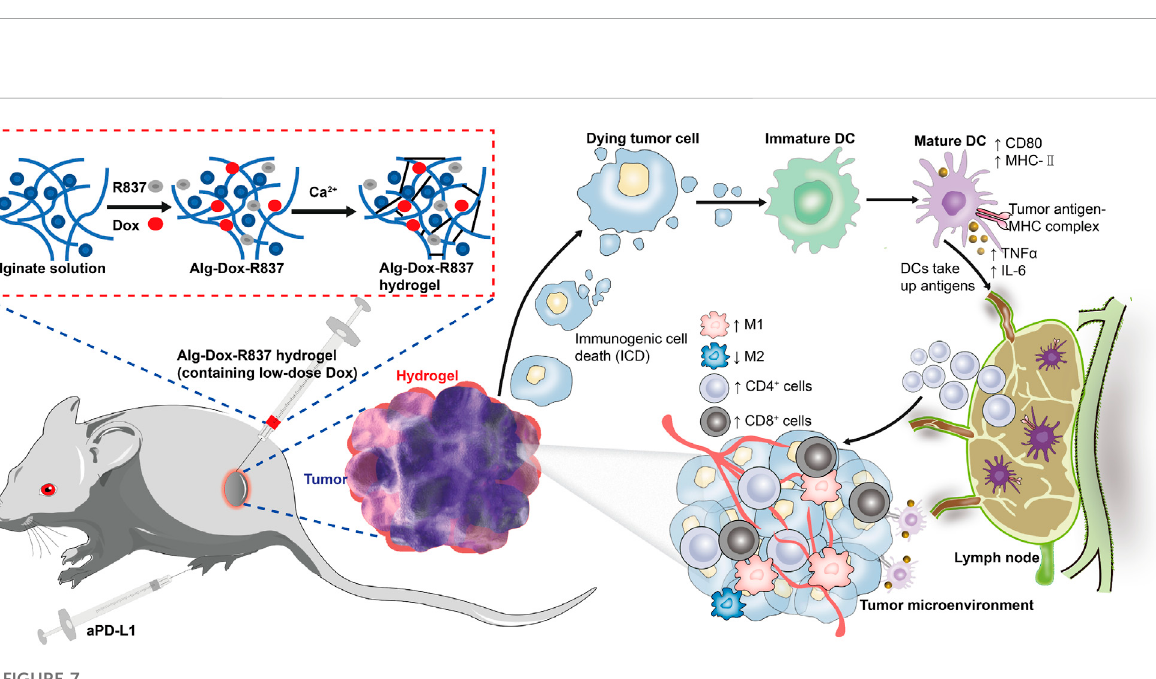
Frontiers in Bioengineering and